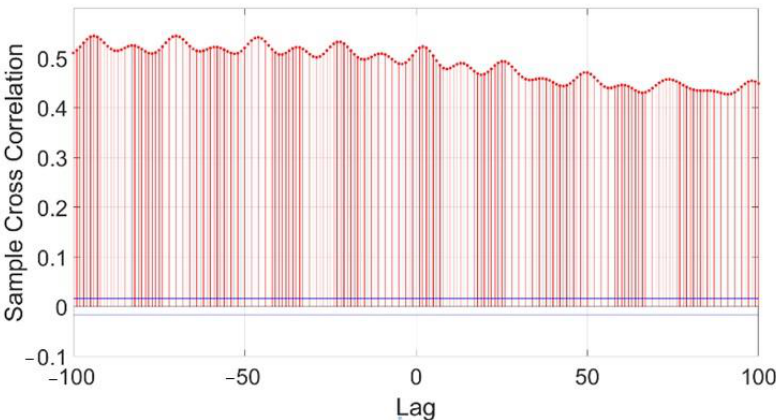
Figure 6. The cross-correlation functions between air temperature and sea level time series.